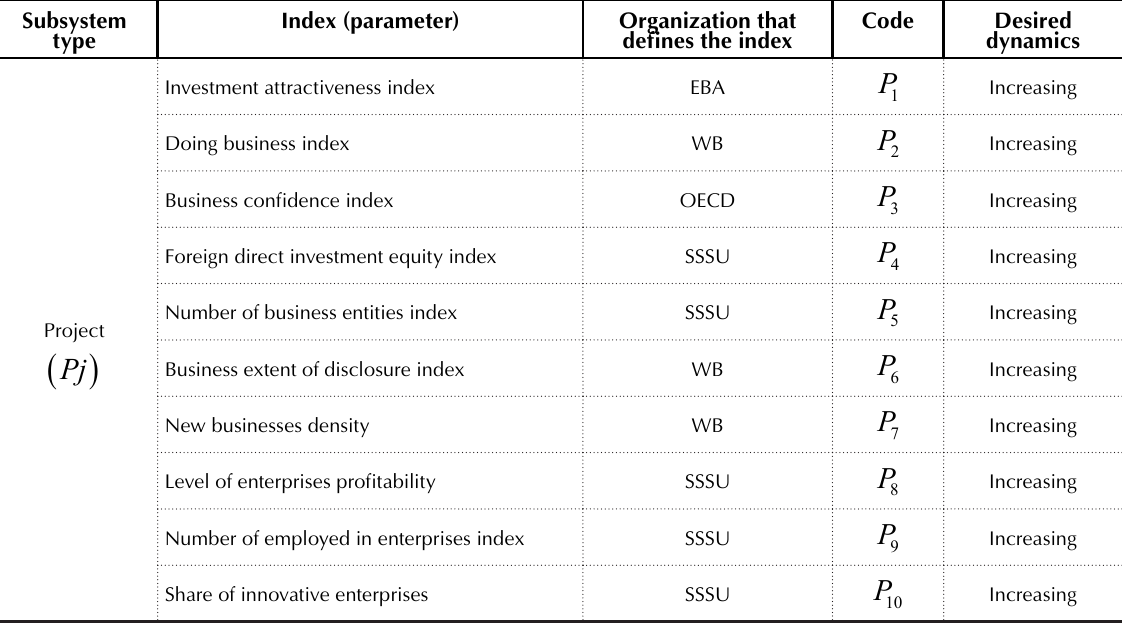
Table 2 (cont). Characteristics of functioning parameters of the subsystems of socio-economic system of